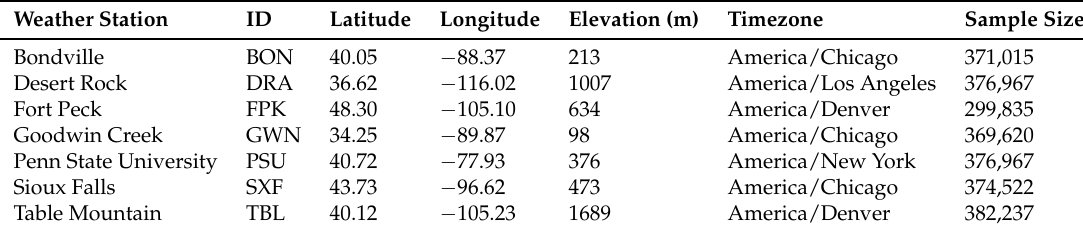
Table 3. SURFRAD weather stations in the U.S. and their locations.